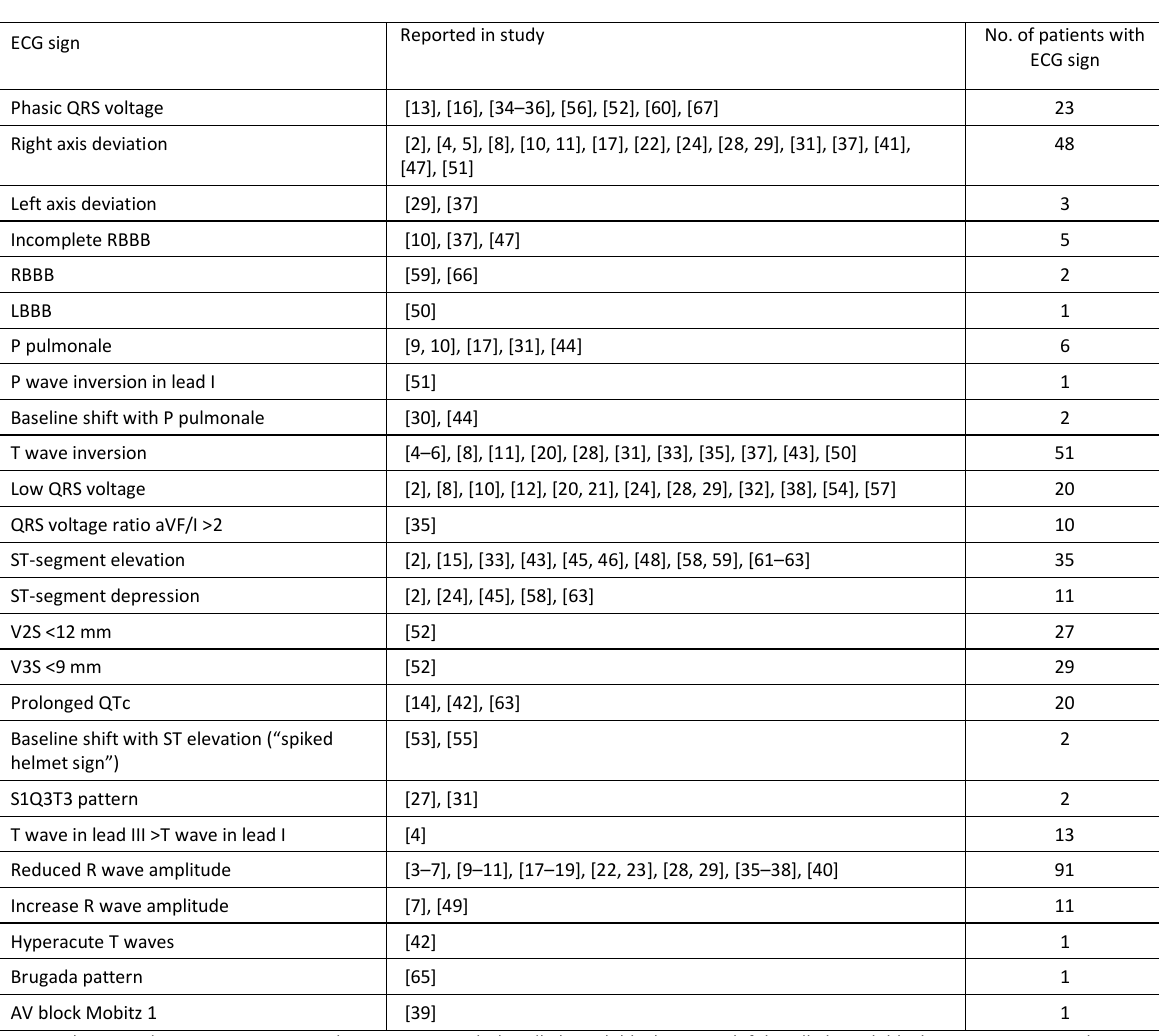
Table A3: ECG signs reported for patients with pneumothorax.